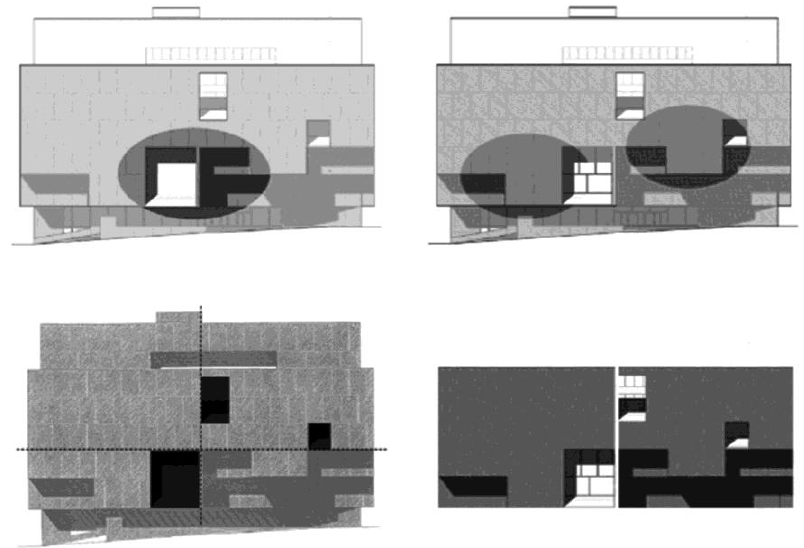
Figure 2. Original façade design—highlighting characteristics of dynamic